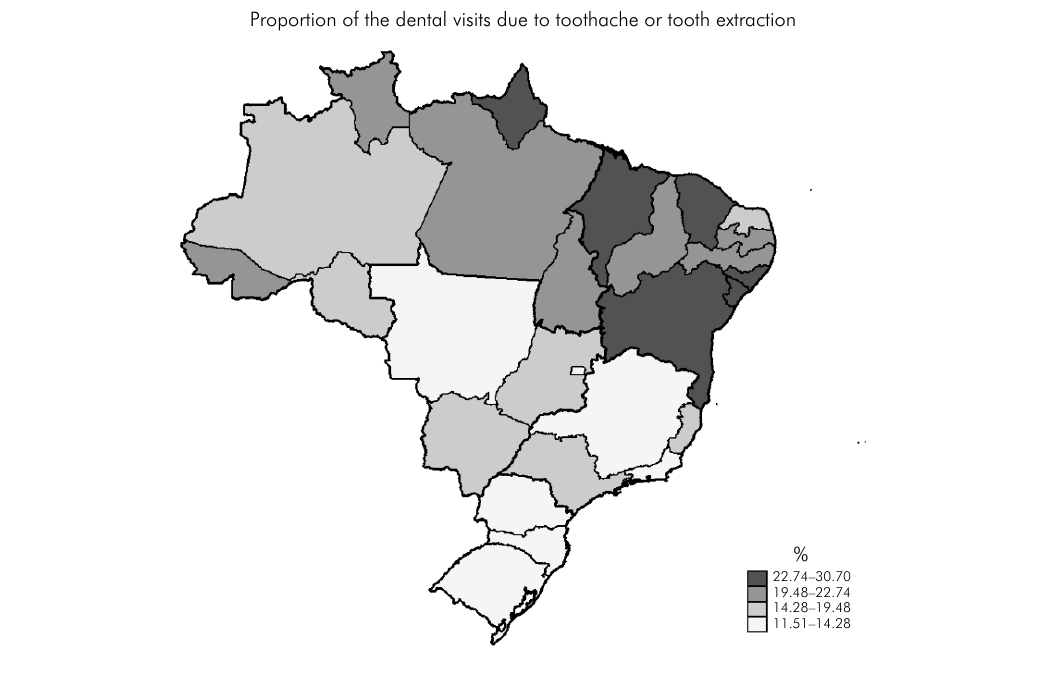
Figure. Proportion of the dental visits due to toothache or tooth extraction in the year prior to the data collection in Brazil, by states. Data was collected from the 2019 National Health Survey (PNS). Footnote: Proportion of dental visits due to toothache or tooth extraction relative to all dental visits in the year prior to the data collection after adjustment for the sample’s